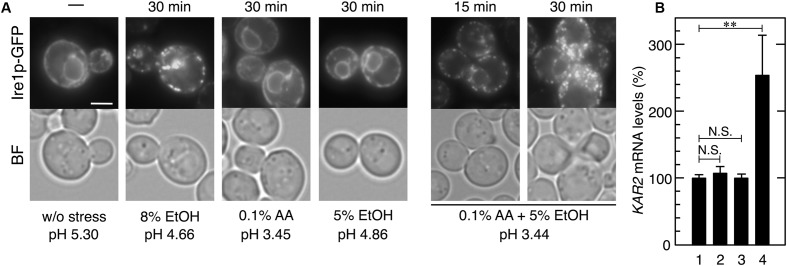
Effects of the combination of mild ethanol stress and mild acetic acid stress on the induction of the UPR. Exponentially growing cells were treated with ethanol (EtOH) and acetic acid (AA). (A) Ire1p-GFP was immediately observed after the treatment without fixation. Representative pictures are shown. BF, bright field. The white bar indicates 3 μm. (B) The mRNA levels of KAR2 were analyzed by qRT-PCR. In order to compare expression levels, the mRNA level of KAR2 was normalized to that of ACT1 under each condition. The mRNA level in cells without a stress treatment was considered to be 100%. Data are shown as the mean ± standard error (n = 3). Lane 1, w/o stress; lane 2, 0.1% AA for 60 min, lane 3, 5% EtOH for 60 min; lane 4, 0.1% AA and 5% EtOH for 60 min. ∗∗P-value < 0.01. N.S., no statistically significant difference.